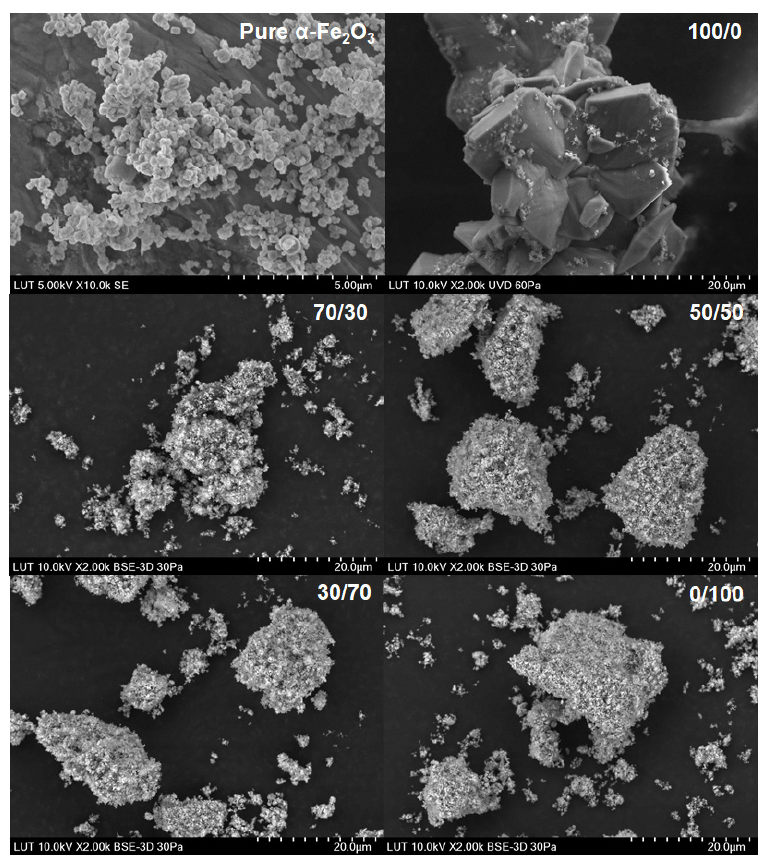
Figure 9. SEM images for the original α -Fe 2 O 3 powder dissolved in different Ox/HNO 3 systems.